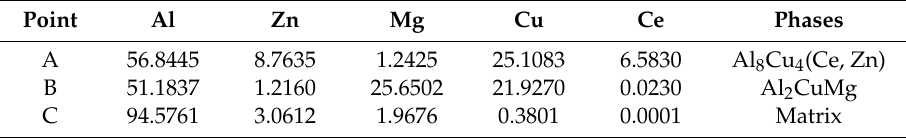
Figure 1. The existing form of Ce and its influence on the segregation of other main elements in the Ce-containing alloy: ( a ) after homogenization; ( b ) after solid solution treatment. Table 3. Chemical composition of intermetallic phases in Figure 1a (at%).